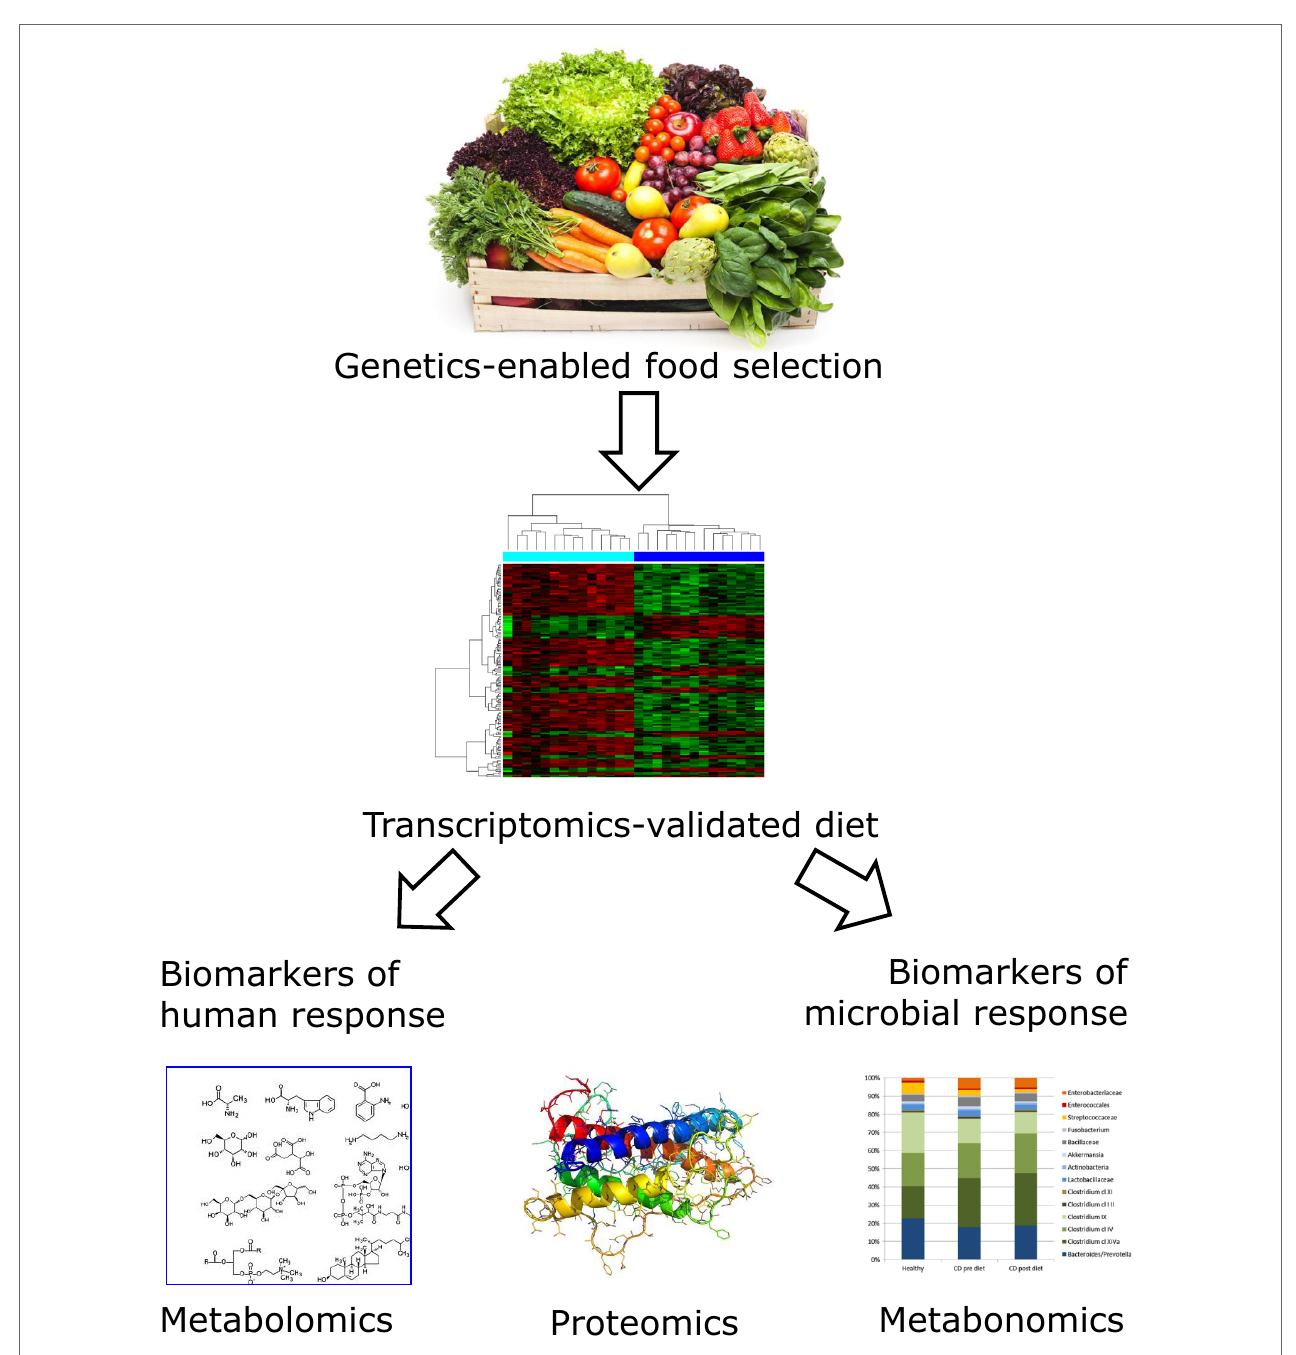
FiGURe 2 | Flowchart showing how genetic and genomic technologies may inform optimal nutritional modulation of CD . Genetic characterization of human DNA and the nature of the associated gut microbiome enable selection of an individualized diet for CD patients. While long-chain omega-3 PUFA containing fish or dietary supplements may be appropriate for most individuals, the exact nature of the most desirable fruits, vegetables, and supplements will vary. Although we are now in a position to make informed guesses, the proof of efficacy of the dietary choice would and probably should be informed by genomic approaches. In particular, there is reason to believe that the inflammation associated with CD will itself consume the various nutrients at higher than average levels. These techniques are now sufficiently sensitive to allow testing the effect of the selected dietary strategy following short-term intervention studies. Blood, urine, and feces samples would be required, before and after the study period. Changes in gene expression as monitored by transcriptomic profiles from peripheral blood mononuclear cells show which CD-related genes have modulated activity (89). Urine or fecal samples can be used for metabolomic and proteomic techniques (91, 94). These may be utilized to monitor dietary compliance and also to provide biomarkers relevant to CD progression. The microbiota profile can be estimated from stool samples, and modulation of microbiota will provide important complementary information on whether the dietary selection has the desired effect on slowing disease progression (67, 89, 95). Images from Adobe stockimages and from Ref.